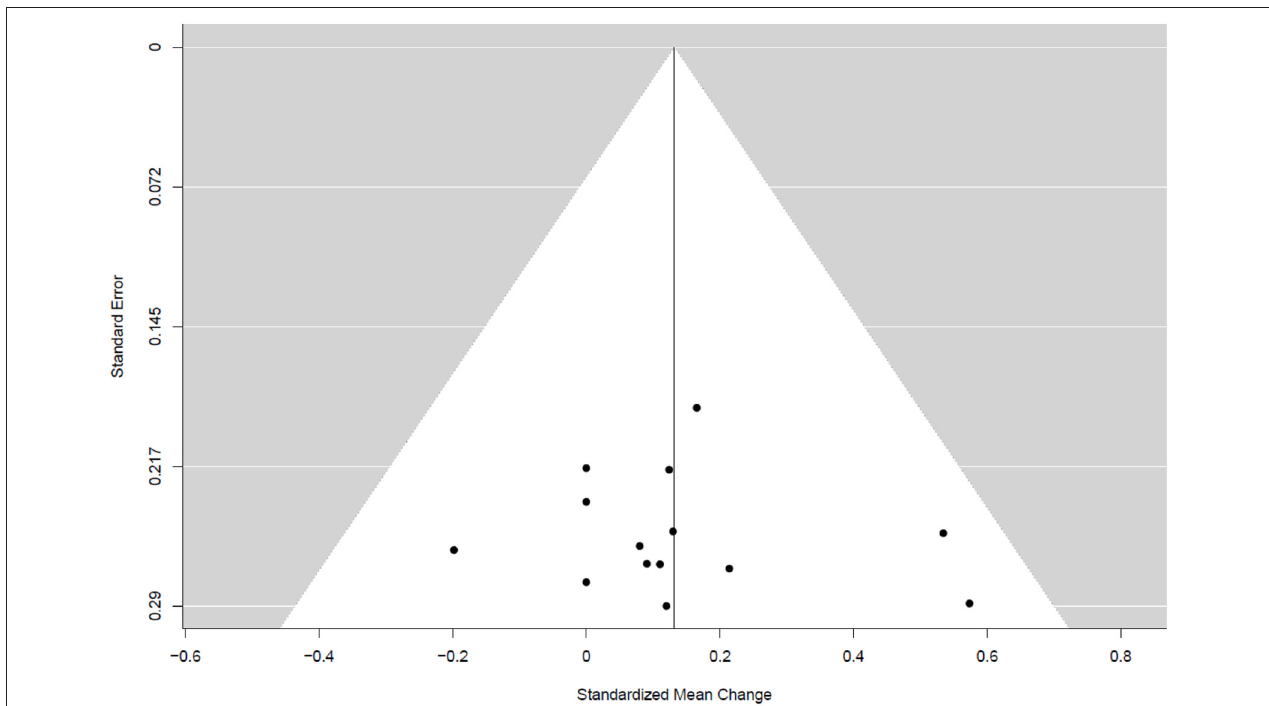
FIGURE 3 | Funnel plots for WB BMD in the whole